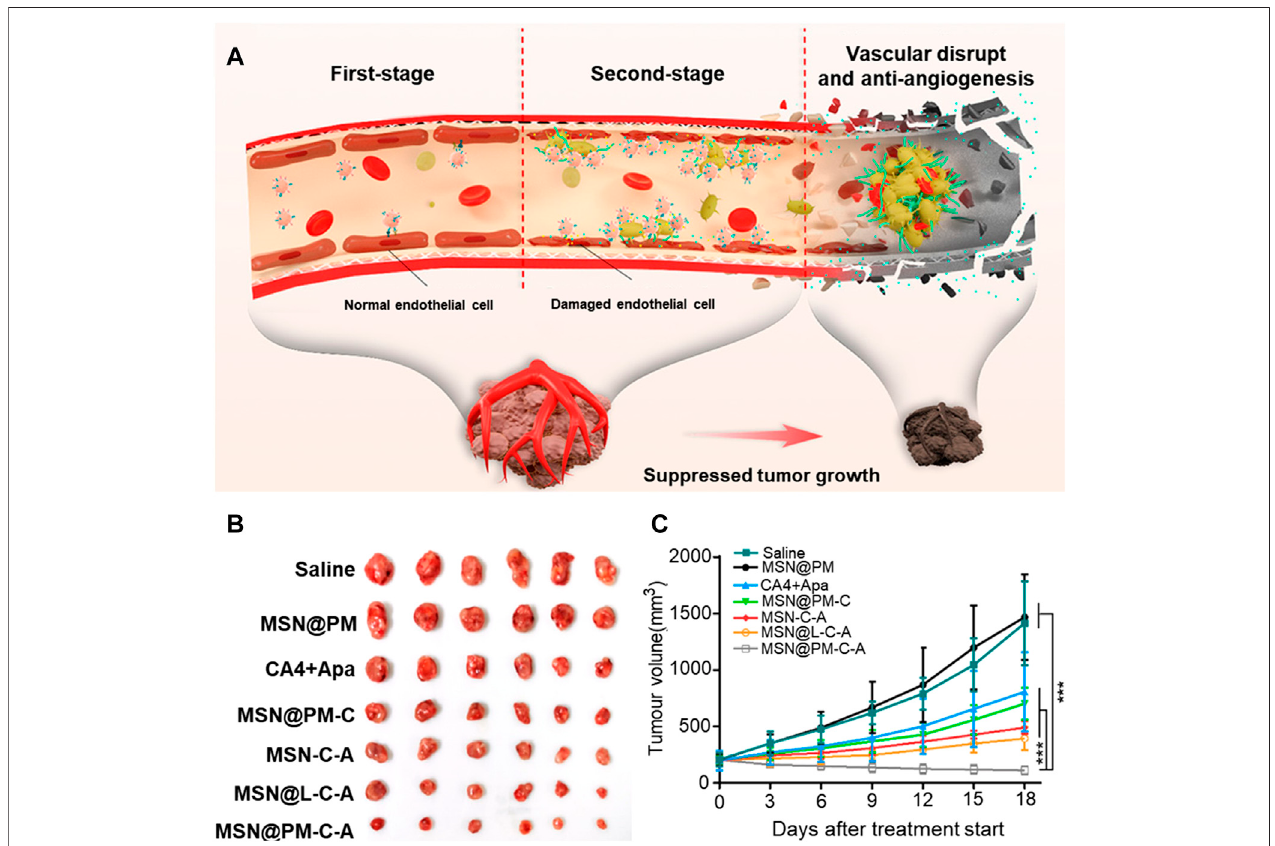
FIGURE 3 | Illustration of the proposed action mechanism and the tumor-killing effect of MSN@PM-C-A in tumor vessels. (A) Proposed antitumor mechanism of MSN@PM-C-A in the tumor-bearing mouse model. (B) Pictures of mice with treatments. (C) Tumor growth curves of MHCC-97H tumor-bearing mice treated with different agents. Reprinted with permission from (Li et al.,